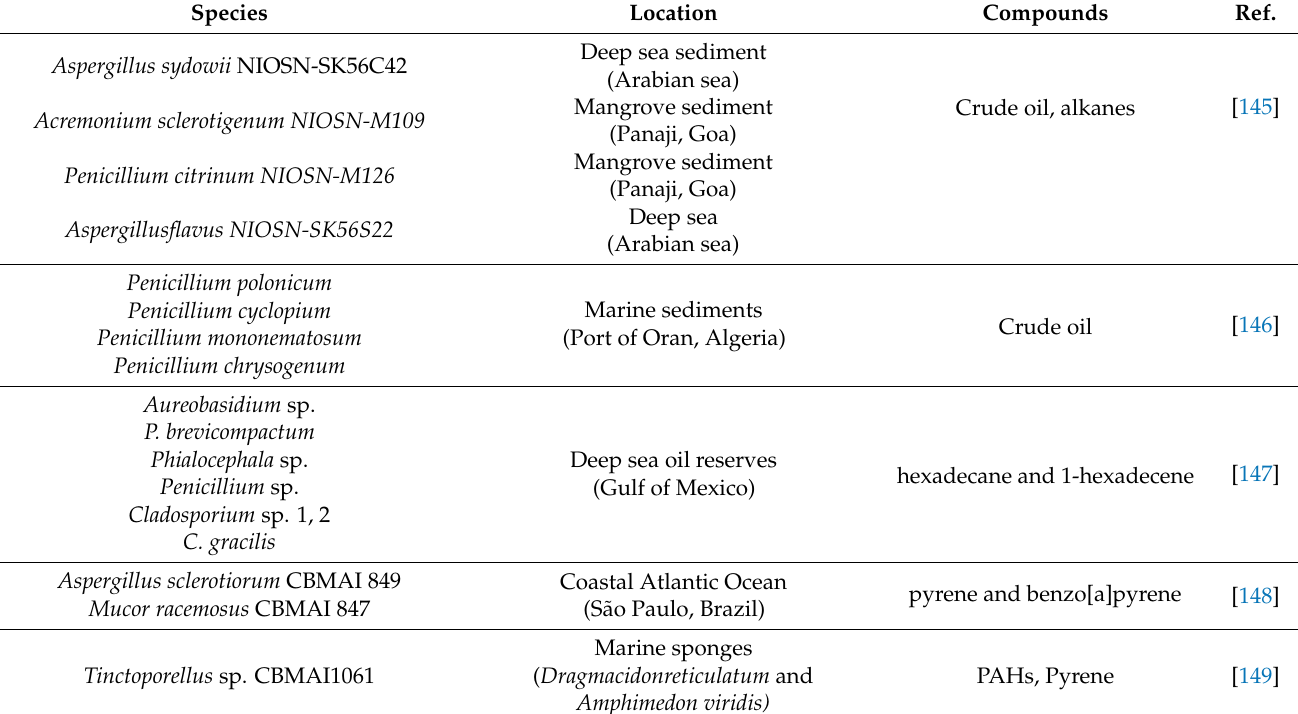
Table 3. List of the main marine fungi hydrocarbon